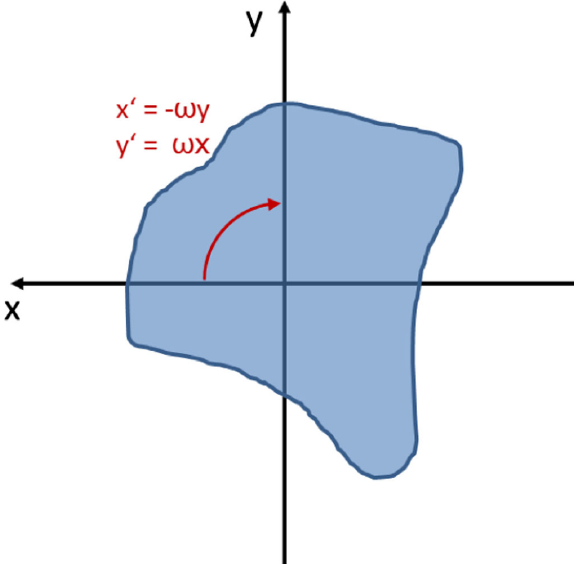
FIG. 3. Arbitrary object rotating rigidly with a constant angular velocity ω around the beam axis.